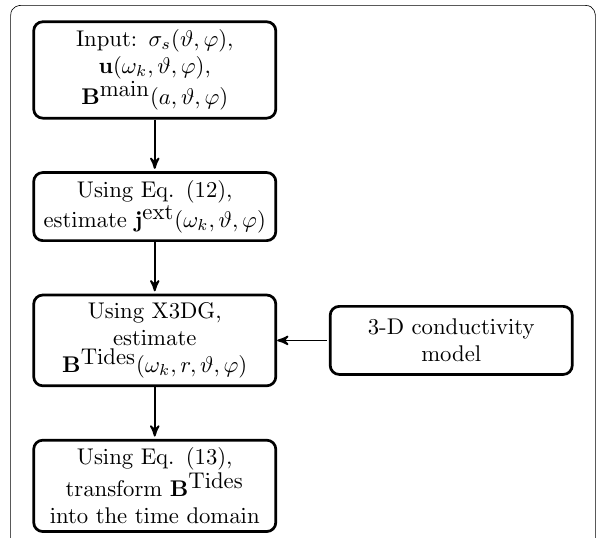
Fig. 4 Work-flow chart used to model magnetic signals due to oceanic tides. As an output, one acquires synthesized tidal magnetic fields at a desired location and time